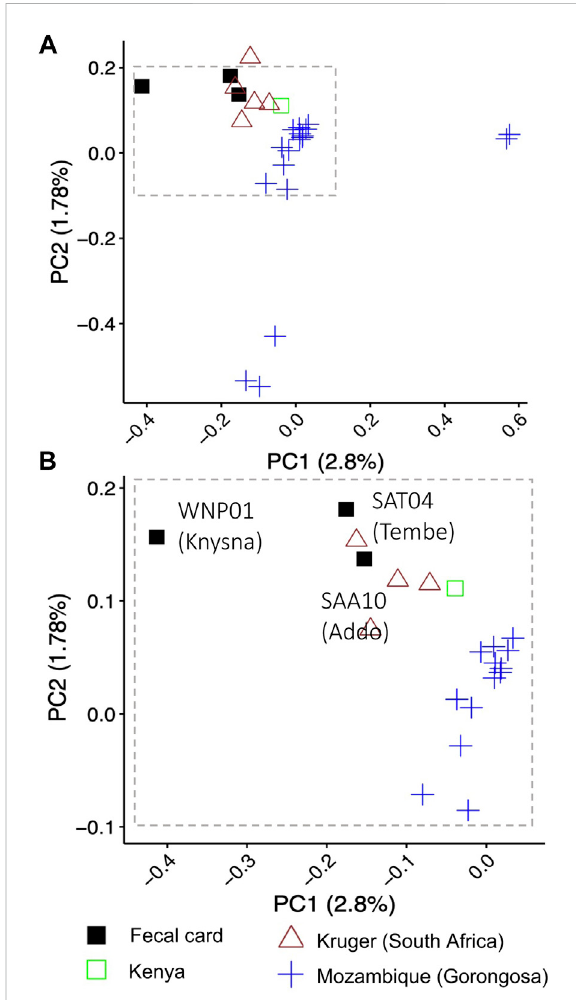
FIGURE 3 Assessment of nuclear genetic variation for free-ranging savanna elephants from South Africa, Mozambique and Kenya. Principal component analysis using nuclear genome-wide SNPs (single nucleotide polymorphisms) supported the geographic partitioningofelephants(n=27)inananalysiscombiningsequences of DNA from elephant dung collected on DNA preservation cards ( “ fecal card ” ) in South Africa with sequences of high-quality DNA from geo-referenced elephant samples from Kruger (South Africa), Mozambique and Kenya. Elephant DNA from dung collected on DNA preservation cards in Addo Elephant National Park and Tembe Elephant Park group with geo-referenced individuals from Kruger NationalParkinSouthAfricathatweresequencedusinghighquality DNA. The Knysna elephant fecal sample (WNP01) does not cluster withtheotherSouthAfricanelephants.PanelAshowstheclustering pattern for all 27 elephants using PC1 and PC2; individuals from Gorongoza do not overlap with elephants from other locations, while the single Kenya elephant is outside the range of values for South African elephants in PC1. Panel (B) shows an enlargement of the top left cluster of individuals in panel (A) . Symbols and colors represent different geographic localities (legend below the